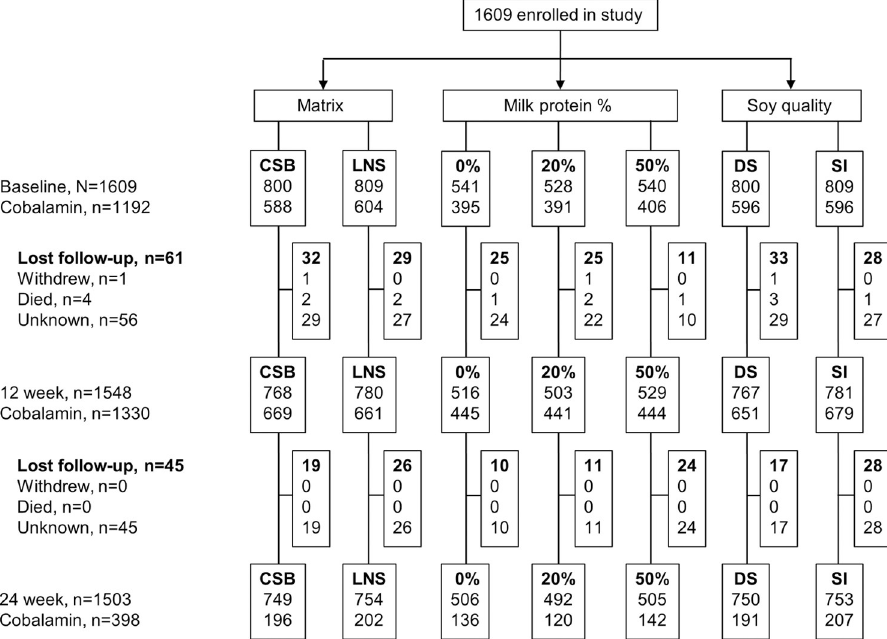
Fig 1. Trial profile. Of 1,609 children enrolled, cobalamin data were available on 1,192 at baseline. After 12 and 24 weeks, 1,548 and 1,503 children were followed up, and cobalamin data were available on 1,330 and 398, respectively. CSB, corn–soy blend; DS, dehulled soy; LNS, lipid-based nutrient supplement; SI, soy isolate.